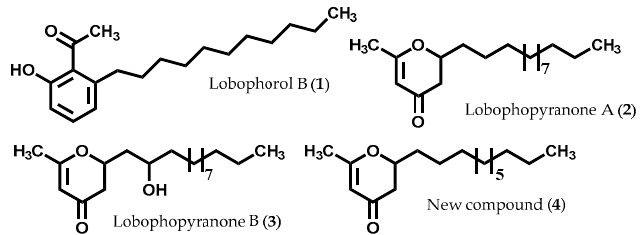
Figure 1. Chemical structure of compounds isolated from beach-cast